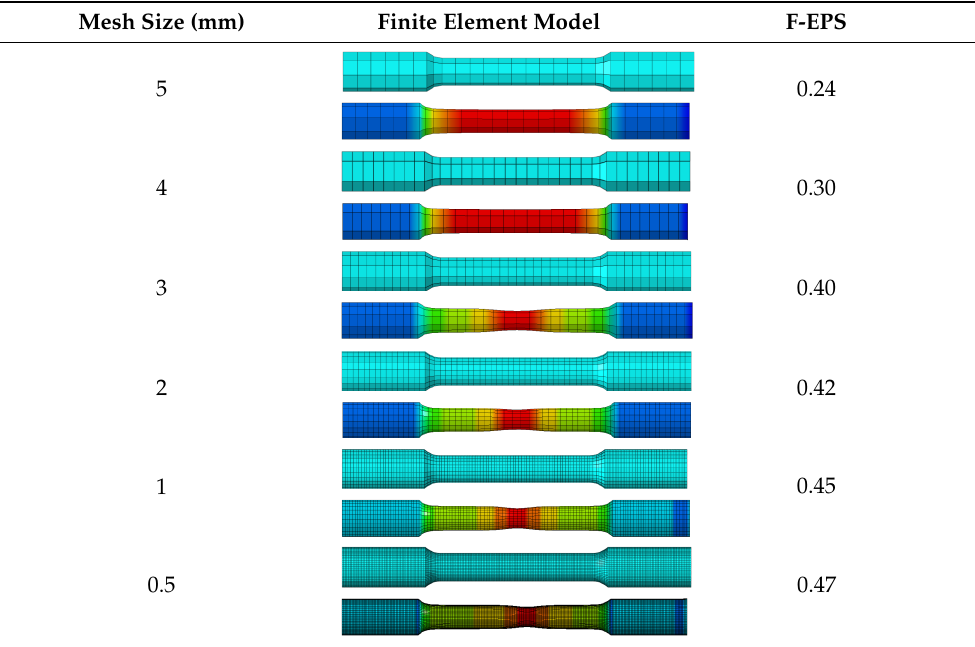
Figure 19. Failure attribute strain of finite element models of specimens with different mesh sizes. Table 5. Comparison of failure-effective plastic strain (F-EPS) of finite element models with different mesh sizes.